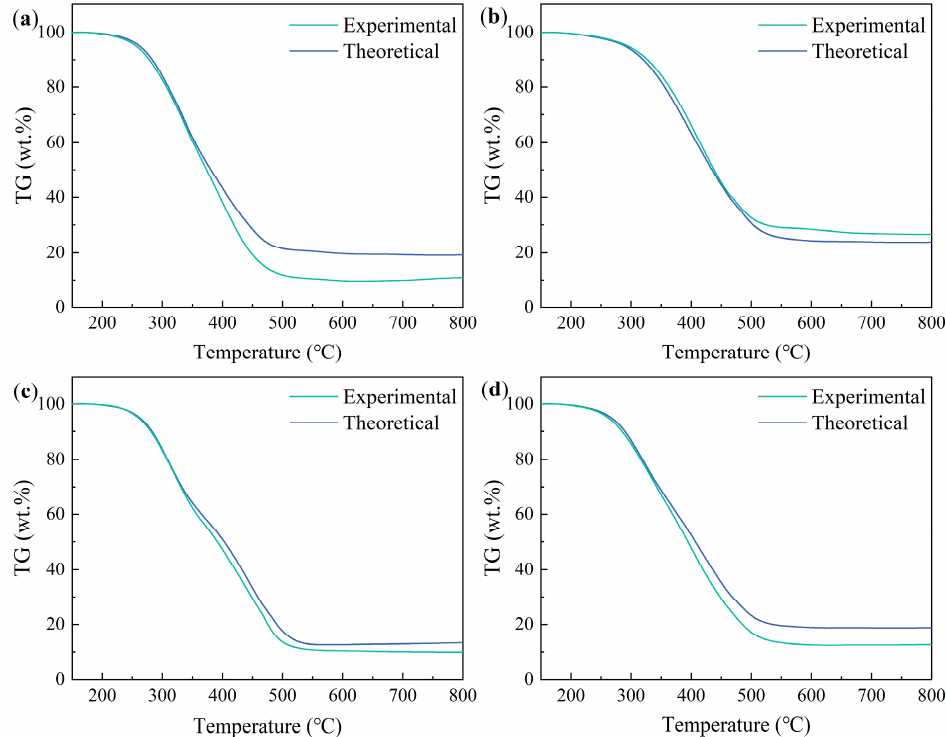
Figure 4. Experimental and theoretical values of the weight loss of ( a ) coal and walnut shell, ( b ) coal and biochar, ( c ) walnut and biochar, and ( d ) coal, walnut shell, and biochar at a heating rate of 10 °C/min.